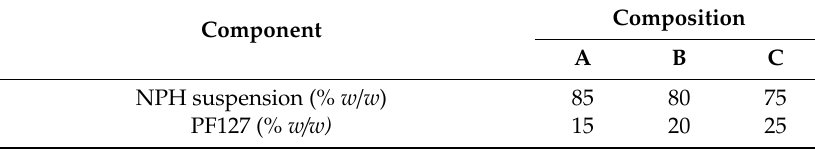
Table 1. Composition of the insulin formulations containing Pluronic F127